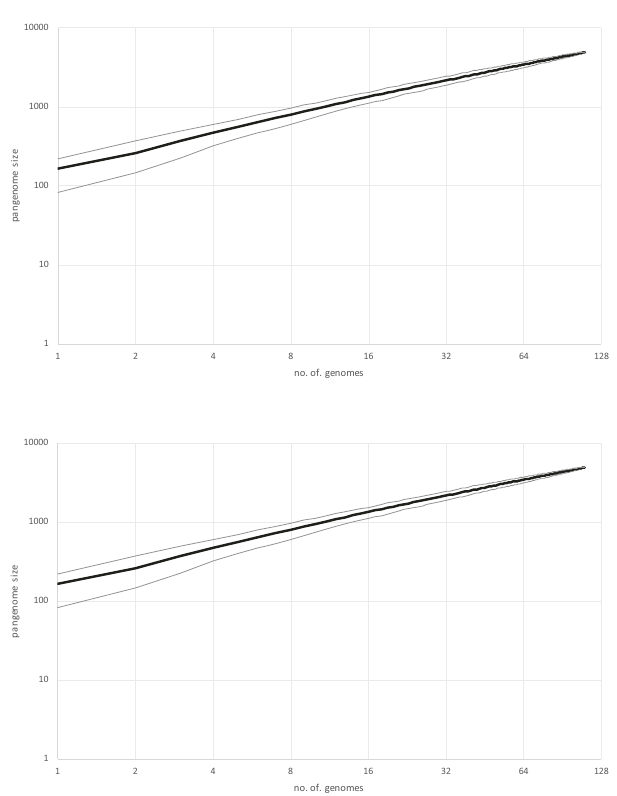
Fig. 4 Rarefaction analysis of the crAss-like phage pangenome. The results of 1001 rarefaction runs for 110 representative genomes are shown. The black line shows the median, and the gray lines show the 5 and 95 percentiles.